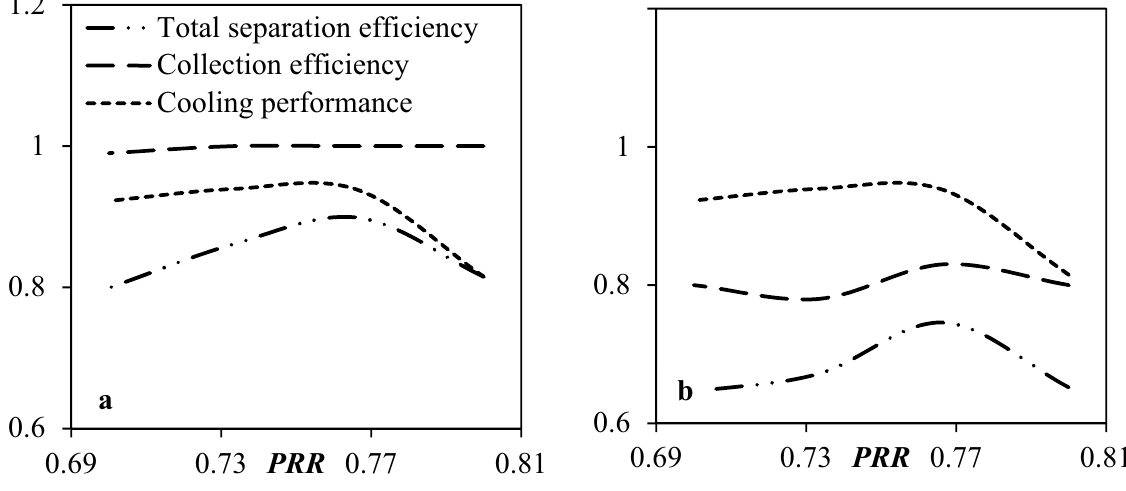
Figure 15. The influence of PRR on the collection efficiency, cooling performance and total separation efficiency of 3S for ( a ) water droplets and ( b ) HC